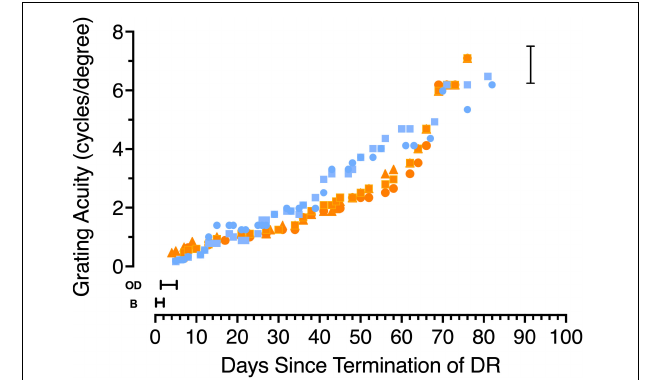
FIGURE 3 | The development of grating acuity in 5 kittens that were reared in total darkness (DR) from birth until 6 weeks of age. Data from the two kittens tested from the first litter are depicted with blue symbols (C115 circles, C116 squares) while orange symbols show data from the second litter (C127 squares, C128 circles and C129 triangles). Periods during which the kittens appeared blind on the jumping stand are indicated by the letter B, while the time during which they were capable of only the ability to discriminate an open from a closed door is indicated by then letters OD. The vertical bracket on the right indicates the range of acuities measured in normal kittens at an equivalent